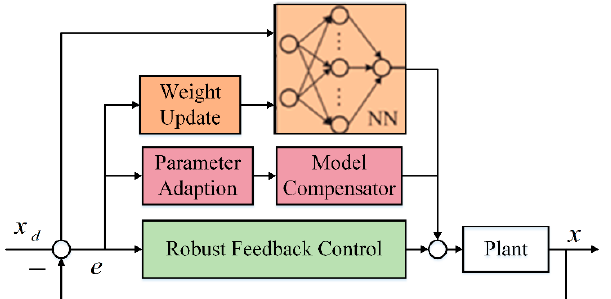
Figure 19. Neural network learning adaptive robust controller framework. Reprinted with permis- sion from ref. [4]. Copyright 2017 IEEE.